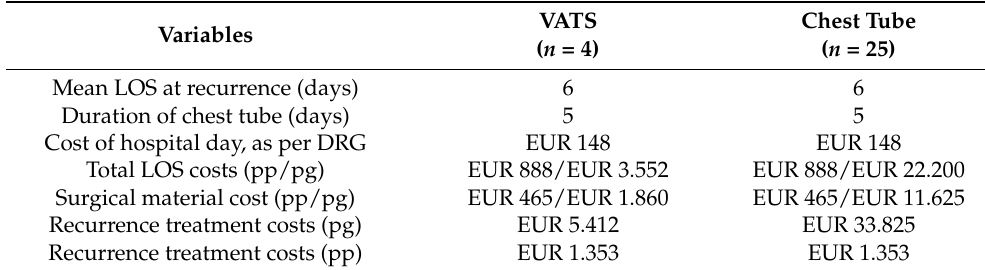
Table 3. Management costs of recurrence.